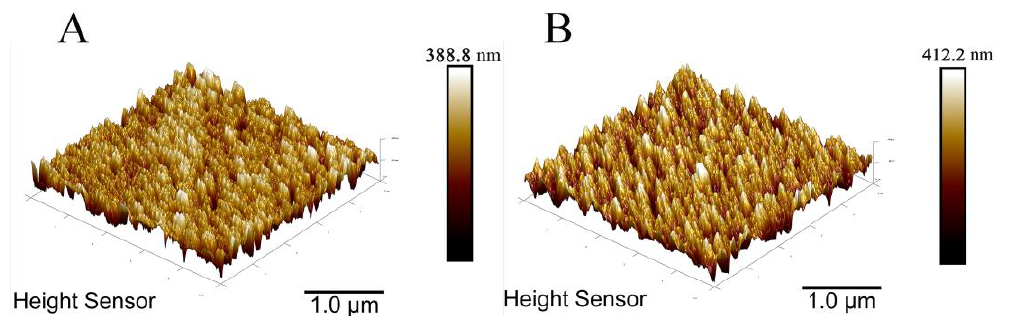
Figure 4. AFM images of AuNPs/NiHCF-NPs/Zn/Fe-ZIF-NPC/GCE ( A ) and Apt/AuNPs/NiHCF- NPs/Zn/Fe-ZIF-NPC/GCE ( B ). Aptamer concentration: 2.0 μ M. Other modification conditions are the same as in Figure 3.